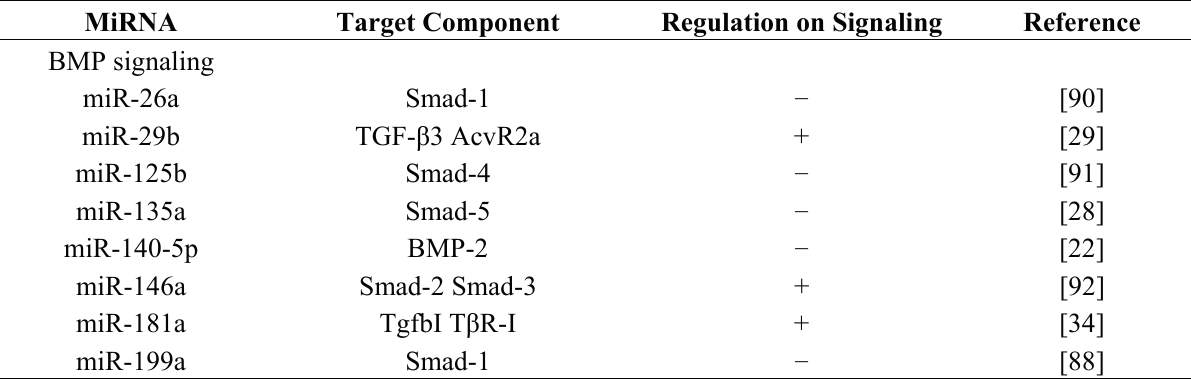
Table 3. MiRNAs in the regulation of osteo-related signaling pathways.